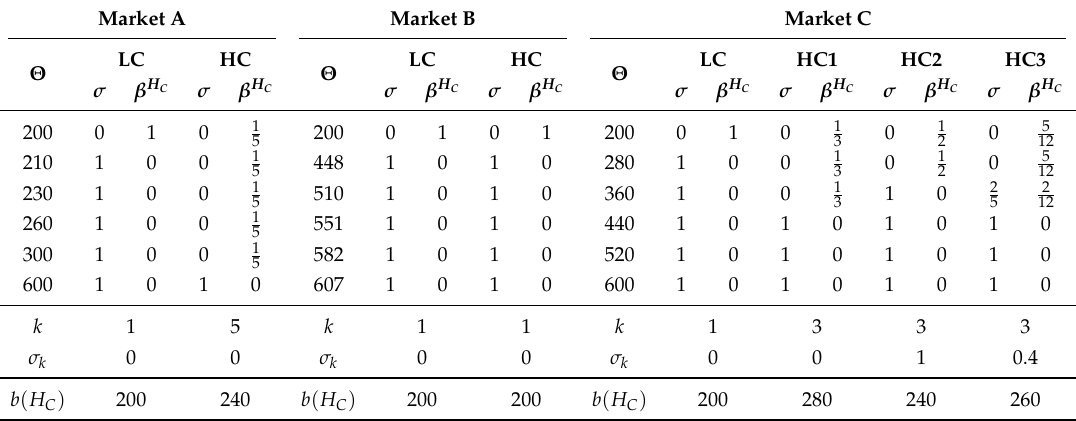
Table 1. Parameterizations and equilibrium predictions for the games used in the experiment. Market